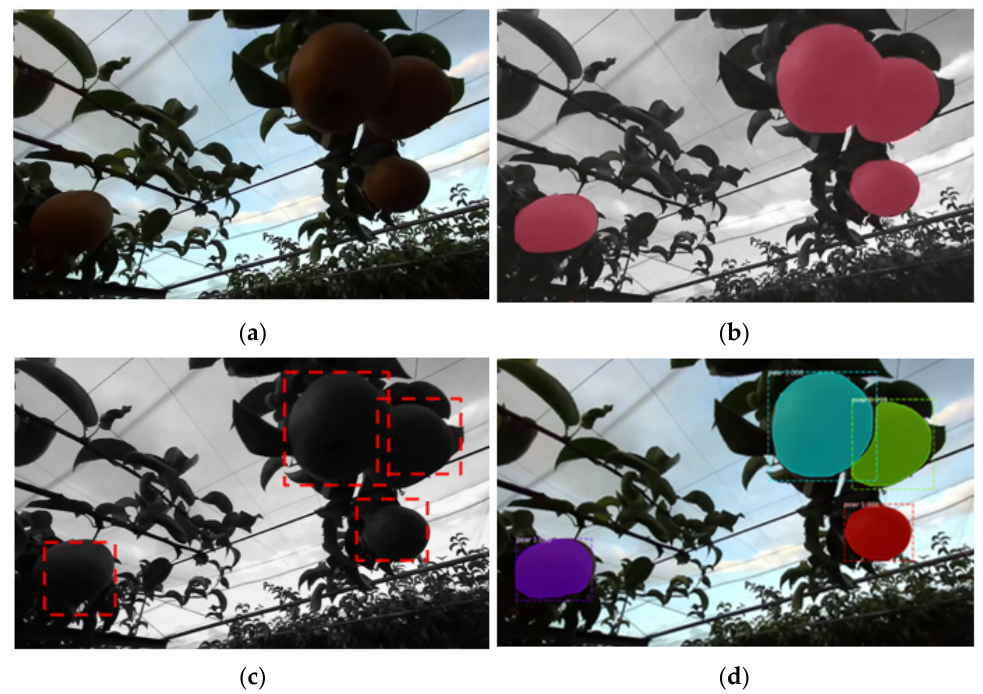
Figure 2. Different segmentation in pear detection using 3D camera datasets, ( a ) original image; ( b ) semantic segmentation; ( c ) object detection and ( d ) instance segmentation.